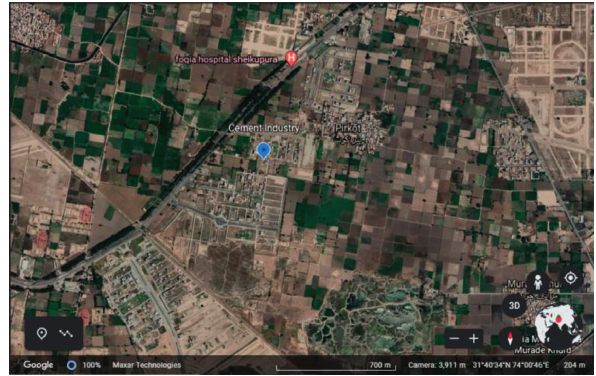
Figure 1: Map of study area (source: Google Earth).